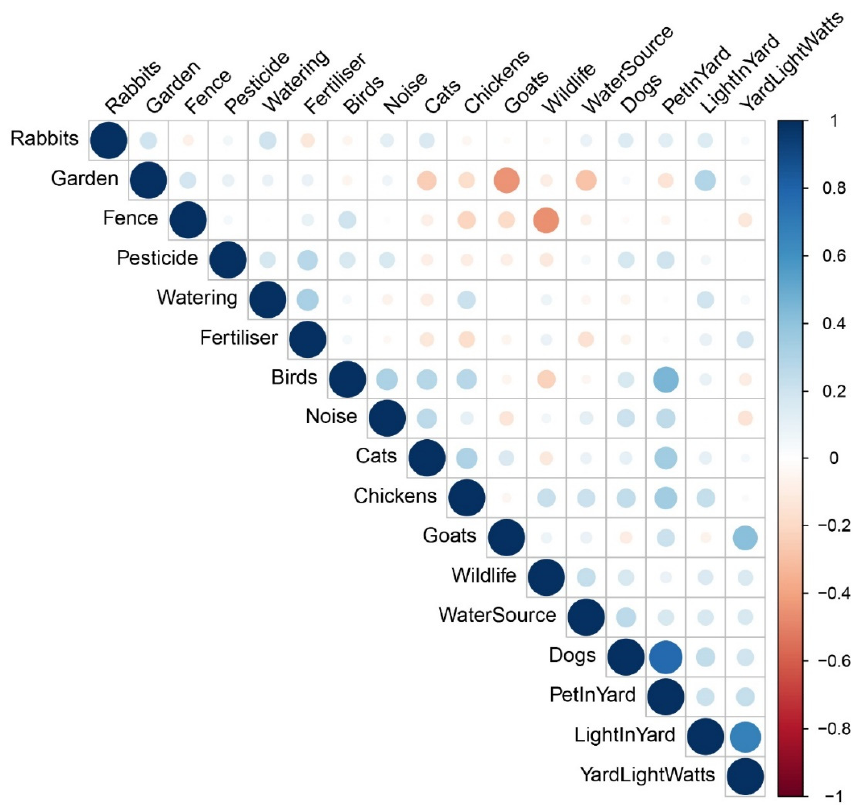
Figure 1. Correlation plot for the number of types of wildlife observed (Wildlife) and variables associated with the data from householders who responded to a questionnaire survey. Positive correlations are in blue and negative in red, and the colour intensity and size of the circle are relative to the level of correlation. Animal variables (rabbits, birds, cats, chickens, goats, dogs, and wildlife) are a total count for domestic pets owned and types of wildlife observed. Pet in yard, light in yard, noise, watering, pesticide, and fertiliser are all categories relative to frequencies they are applied to/in yards, with increases relative to increased applications. Garden is categorised relative to modification, ranging from the least to most. Fence is categorised relative to the wildlife access it permits based on the material and gaps to the ground, ranging from most access to least. Yard light watts is categorised to increase relative to the wattage. Water source is a yes (1) or no (0) category, relative to if an open water source is kept in a yard. Table 2. Analyses of similarity results testing the number of types of wildlife observed at a property against each categorical variable independently.